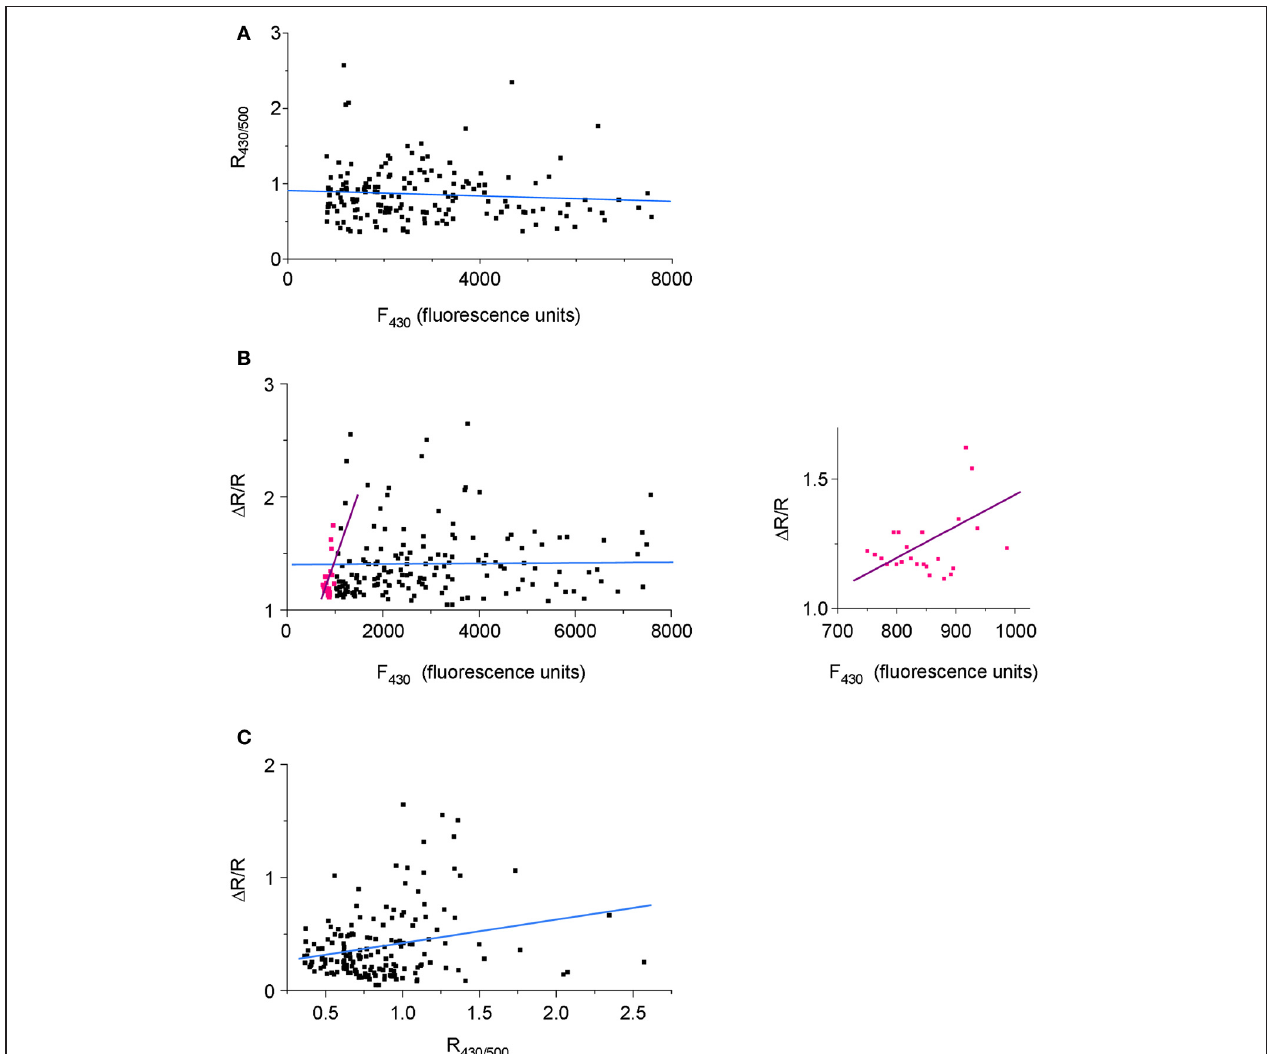
(cid:3) R/R values measured in range of 700–999 relative units of fluorescence. Black dots show (cid:3) R/R in range of 1000–8000 units. The straight lines are best linear fits of the corresponding cell populations. The inset plot shows the distribution of pink points from principal plot at different time base. (C) Correlation between the magnitude ( (cid:3) R/R) response and basal level of R 430 / 500